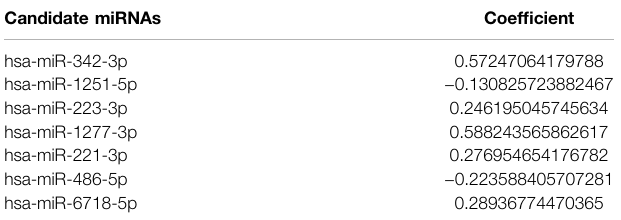
TABLE 2 | Seven candidate miRNAs and their corresponding coef fi cients were obtained by multivariate Cox regression analysis. Candidate